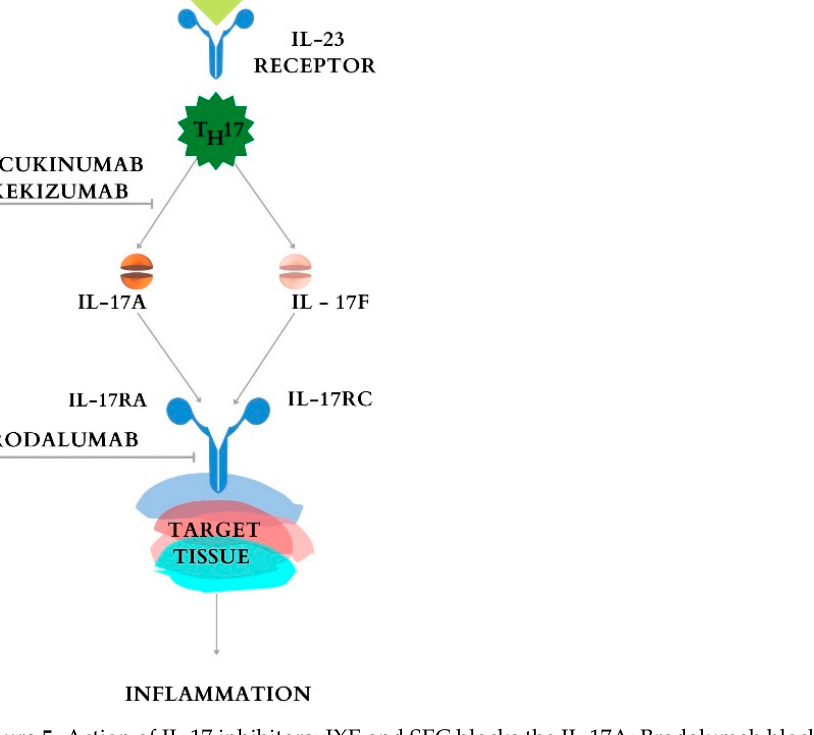
Figure 5. Action of IL-17 inhibitors: IXE and SEC blocks the IL-17A; Brodalumab blocks the receptor of IL-17A (IL-17RA).